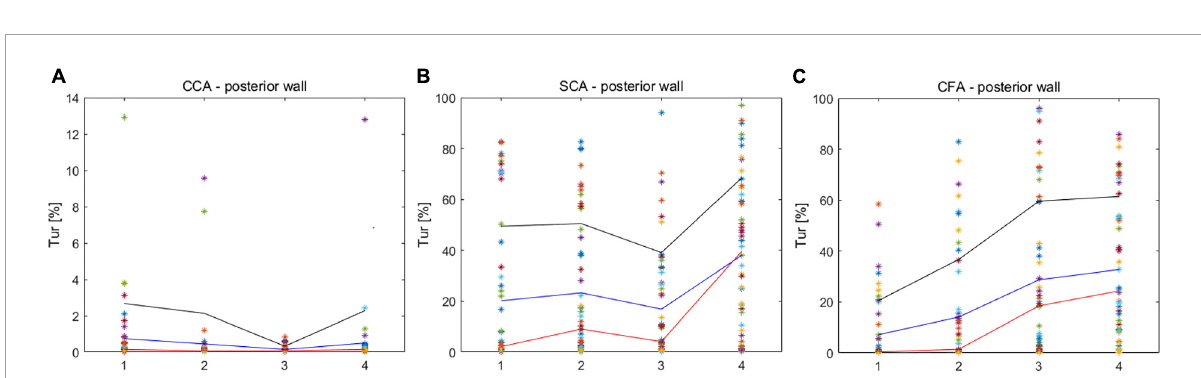
FIGURE3 Turbulence index (Tur) values corresponding to different locations in early-systole, mid-systole, late-systole, and early diastole. (A) CCA corresponds to the Tur value of four stages; (B) SCA corresponds to the Tur value of four stages; (C) CFA corresponds to the Tur value of four stages. CCA, common carotid artery; SCA, subclavian artery; CFA, common femoral